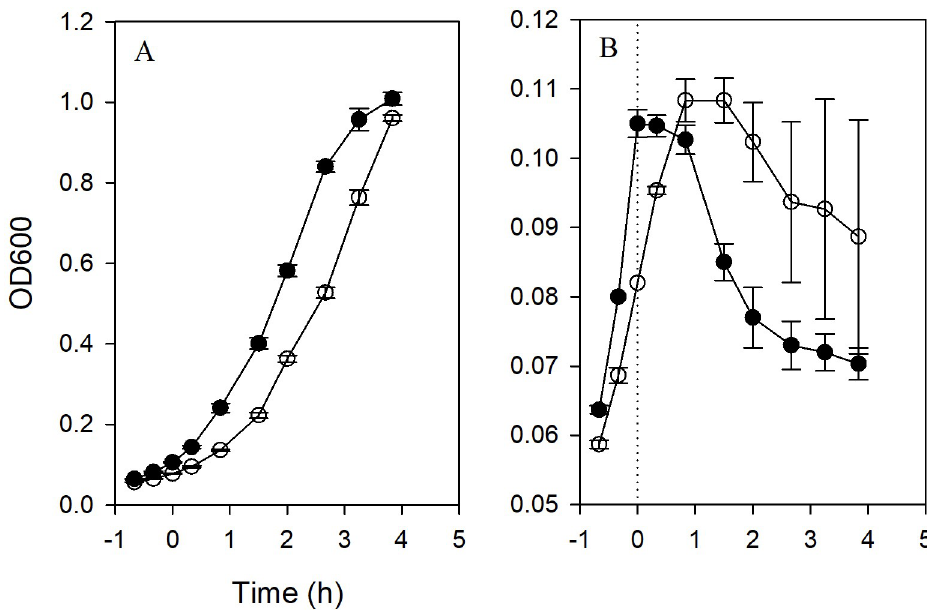
Fig 7. The ARF48 toxic effect is enhanced in medium containing NaCl. E . coli BL21 cells transformed by pARF48 were grown in standard LB broth, which contains 0.17 M NaCl (filled circles), or in modified LB that lacked NaCl (open circles). A, growth rates of non-induced cultures; B, growth rates of cultures treated with aTc at early log phase to induce expression of ARF48. The experiment was performed with triplicate cultures for each condition, and the mean +/- standard deviation of the OD600 measurements at each time point were